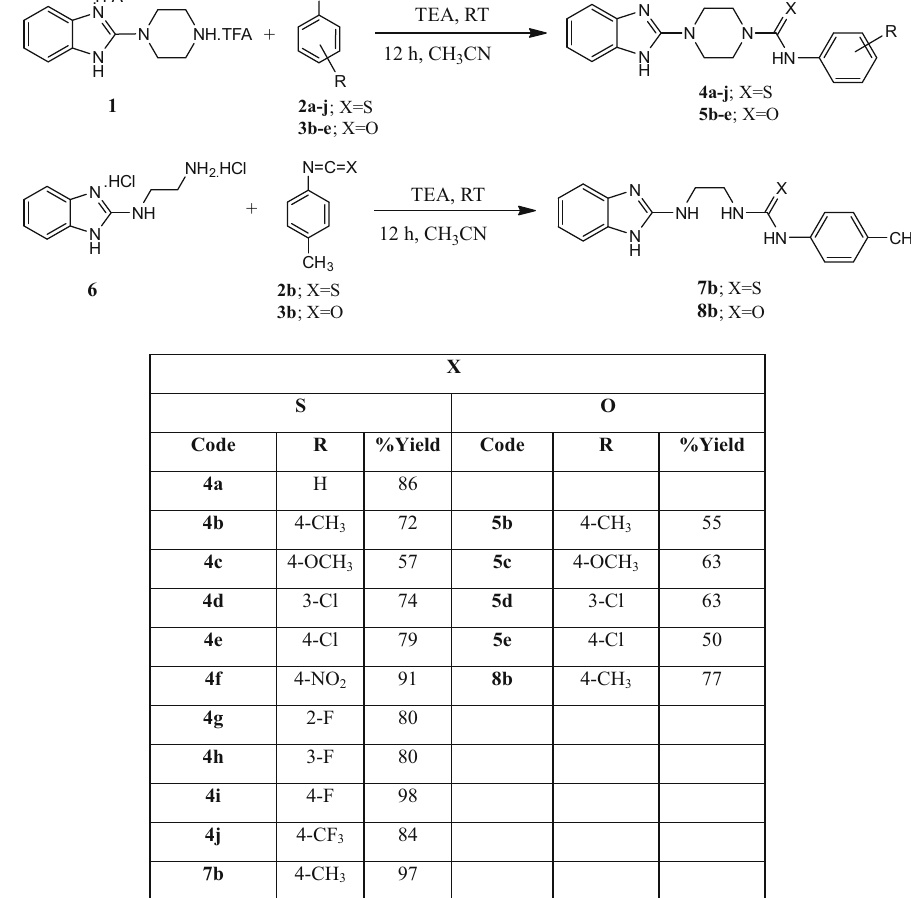
Scheme 1: Synthesis of benzimidazole thiourea ( 4a – j, 7b ) and benzimidazole urea ( 5b – e, 8b )